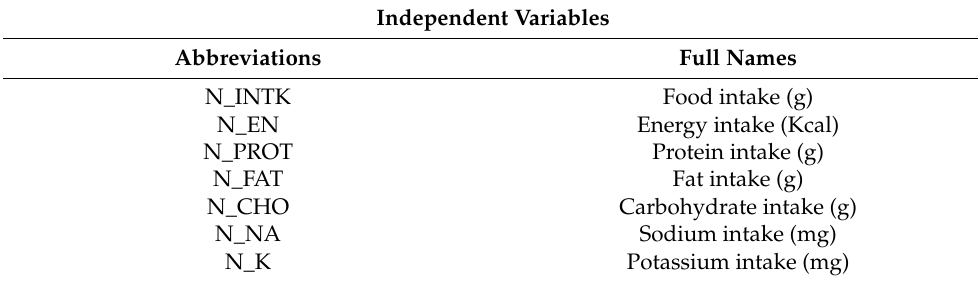
Table 1. Classification of independent